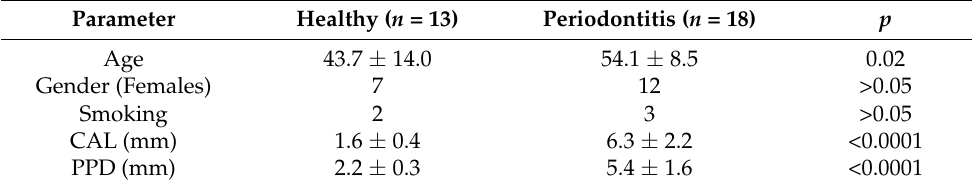
Table 1. Demographic characteristics of study